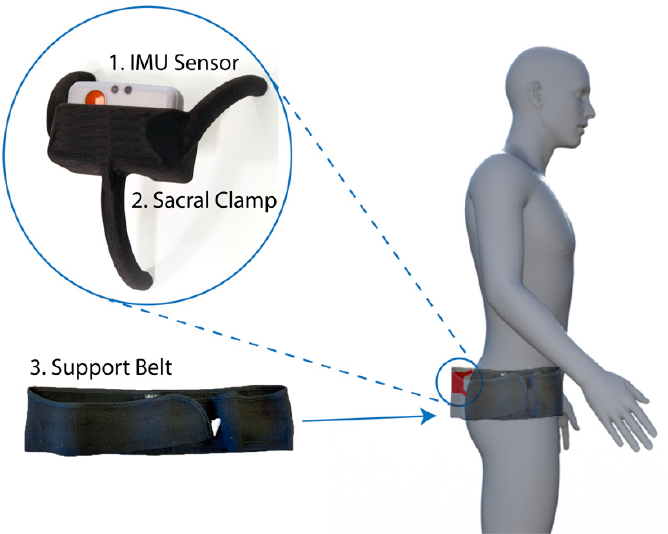
Figure 1. Device components and fitting location. The device consisted of three components: Inertial measurement unit (IMU) sensor (1), a bespoke sacral clamp (2), and support belt (3). The device was attached across the sacrum and held in place by the belt.